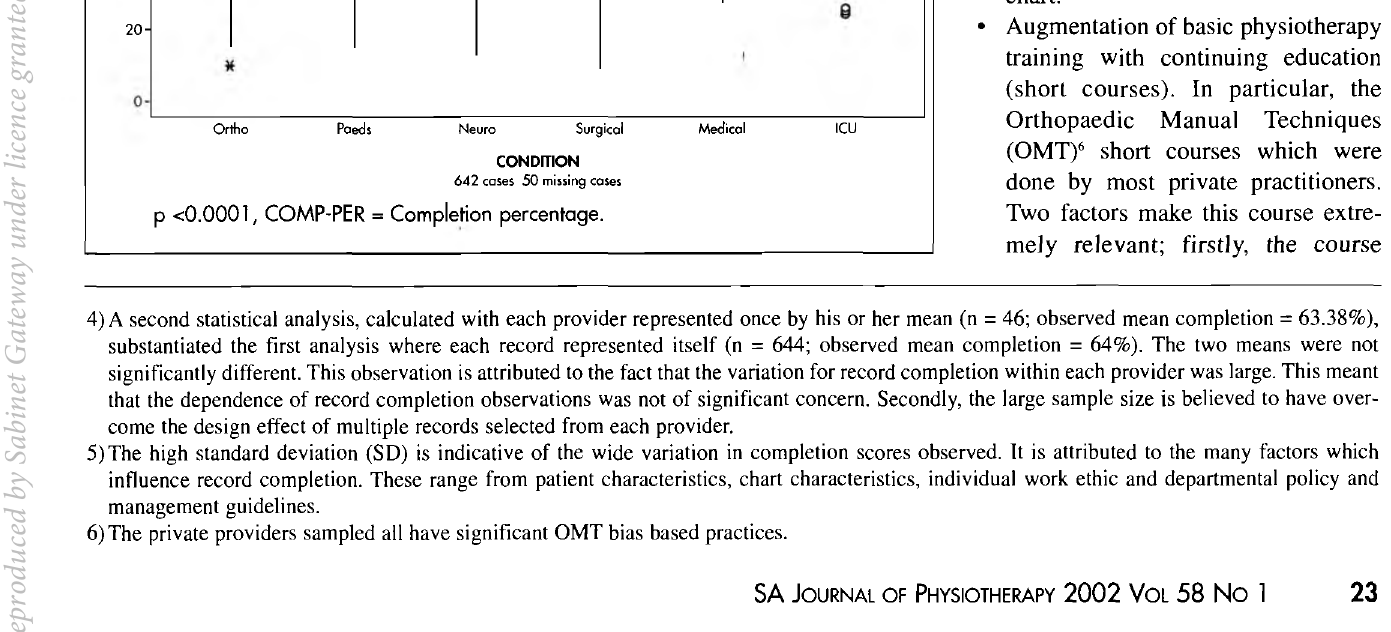
Figure 3: Record Completion for Different Patient